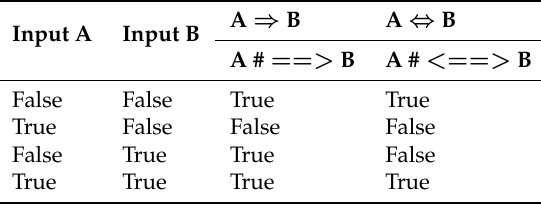
Table 1. Truth table for the material implications ( ⇒ ) and logical equality ( ⇔ ). Note: # indicates a Prolog notation.